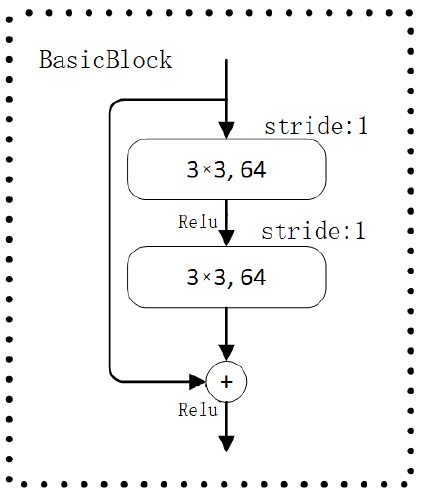
Figure 3. The details of Res Block.